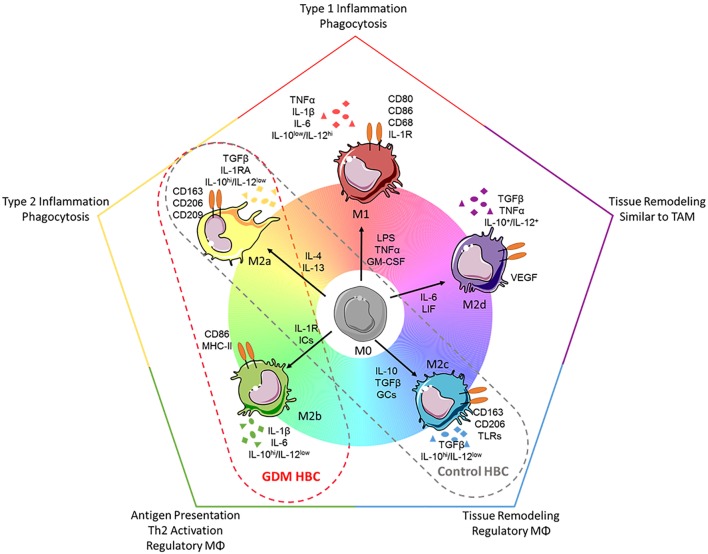
Polarization spectrum of human macrophages and how to apply it to Hofbauer cells (HBC). Upper panel: current knowledge about macrophages. Despite the fact that macrophages may be polarized in many intermediate states of the spectrum presented here [adapted from Ref. (11)], generally macrophages are divided into the two categories: M1 (classical/pro-inflammatory) and M2 (alternative/anti-inflammatory). Because of the huge range of macrophage plasticity, the M2 phenotype has been further divided into the subsets M2a, M2b (which shares features of M1), M2c, and M2d macrophages. Each subset can be distinguished looking at (1) induction by certain cytokines, (2) expression of surface markers, (3) release of certain cytokines, or (4) their functionality (phagocytic vs. regulatory or remodeling). Lower panel: HBCs in the presented study. In our study, HBCs isolated from control placental tissue displayed features of the M2a and M2c phenotype, e.g., high expression of CD209 and low secretion of interleukin (IL)-6. HBCs isolated from diabetic placenta, on the other hand, displayed some features attributed to M2b phenotype, e.g., elevated (but not significant) expression of the surface marker CD86, and increased (however, also not significant) release of IL-1β and IL-6. Importantly, independent of diabetes during pregnancy, all HBCs in this study were characterized as IL-10hi/IL-12−, a characteristic separating also M2b cells clearly from M1 polarized macrophages. Abbreviations: ICs, immune complexes; GCs, glucocorticoids; TAMs, tumor-associated macrophages; VEGF, vascular endothelial growth factor. Drawings of macrophages have been adapted from Servier Medical Art (http://www.servier.com/Powerpoint-image-bank), permission is granted under a Creative Commons 3.0 unported license (https://creativecommons.org/licenses/by/3.0/).